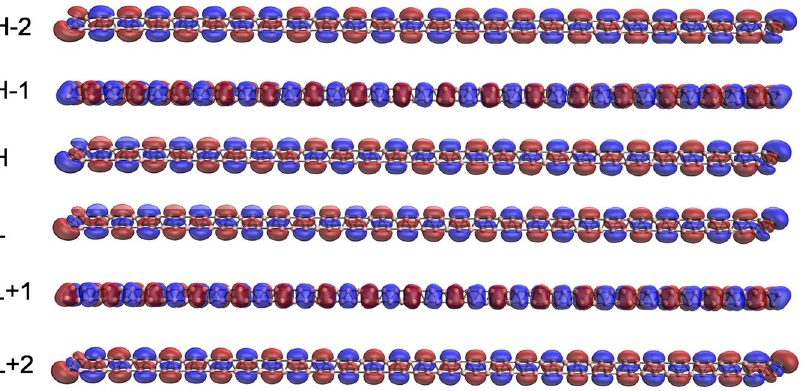
Figure 9. Visualization of the HOMO − 2 (1.634), HOMO − 1 (1.294), HOMO (1.273), LUMO (0.806), LUMO + 1 (0.661), and LUMO + 2 (0.409) for the ground state of l -BNR[2,60], obtained from spin-restricted TAO- LDA, at isovalue = 0.02 e/Å 3 . The orbital occupation numbers are shown in parentheses. Here, for simplicity, HOMO and LUMO are referred to as H and L, respectively.